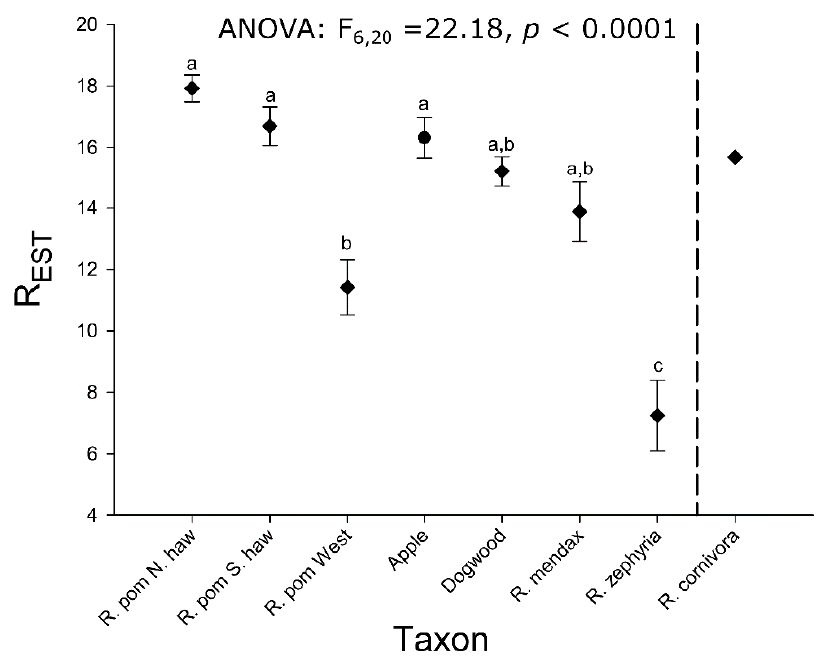
Figure 1. Mean estimated allelic richness ( ± SE) across 19 microsatellite loci for R. pomonella species complex members, based on fitting rarefaction curves to a asymptotic model. Lowercase letters reflect significant differences based on Tukey’s post hoc test. R. cornivora , to the right of the dashed lines, lacks error bars and post hoc test significance designations because only a single population of this taxon was analyzed.